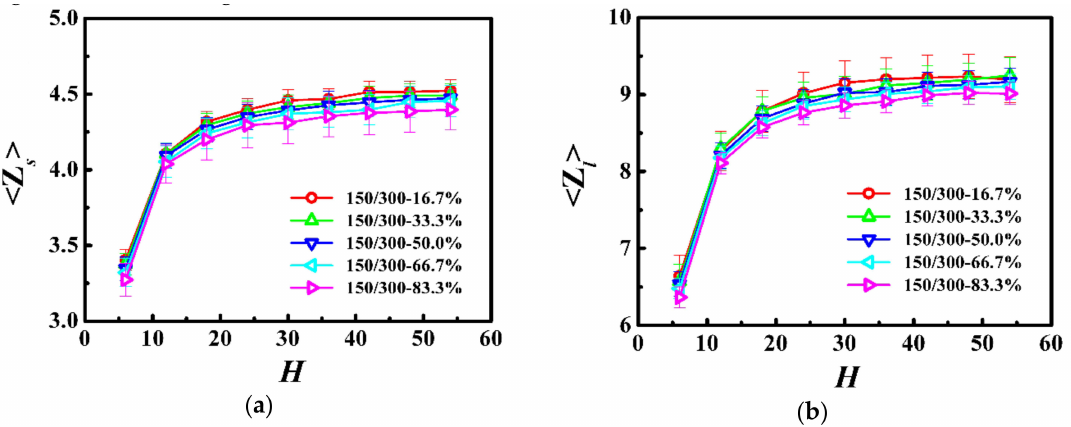
Figure 6. Average number of entanglements for each ( a ) shorter ( (cid:104) Z s (cid:105) ) and ( b ) longer ( (cid:104) Z l (cid:105) ) chain as a function of the film thickness ( H ) in the model system of N s = 150 and N l = 300.